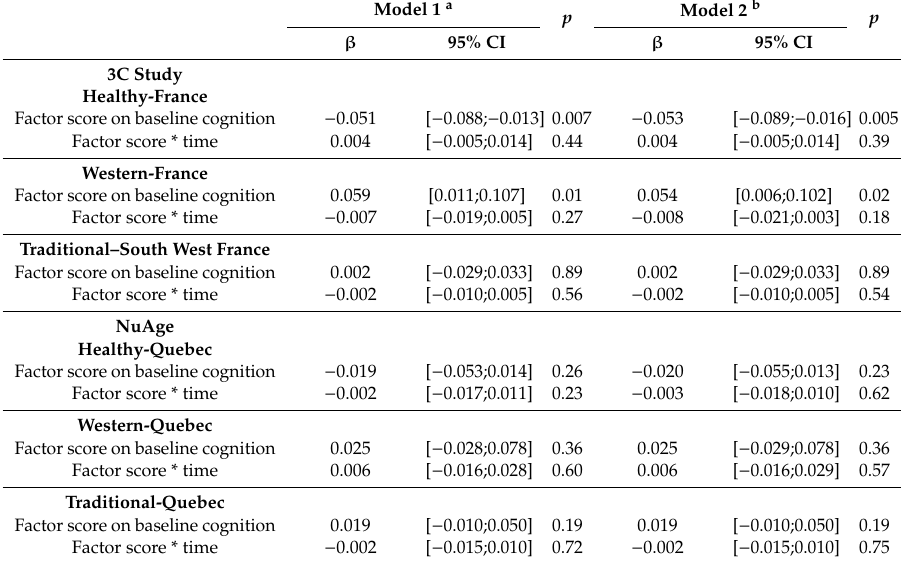
Table 3. Associations between nutrient factor scores and baseline cognition, and slope of cognitive change (square root of the number of errors in the MMSE) in mixed models in 3C and NuAge